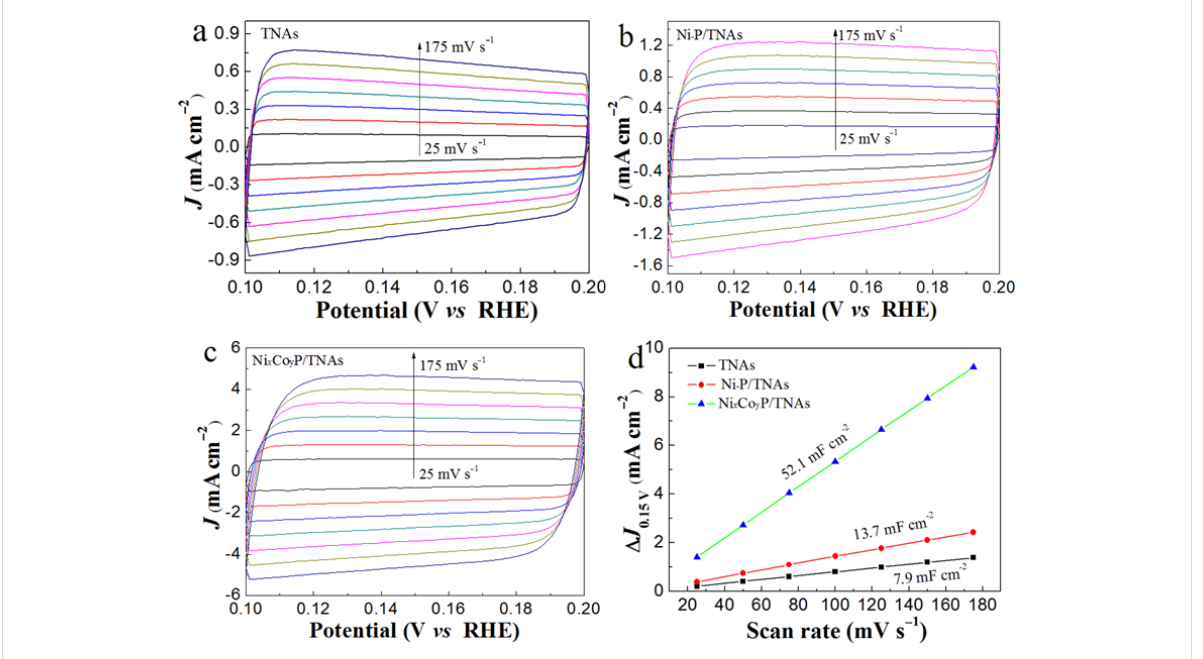
Figure 7: Cyclic voltammograms of (a) TNAs, (b) Ni–P/TNAs and (c) Ni x Co y P/TNAs at various scan rates (25–175 mV s − 1 ), and (d) corresponding current density scan rate curves to estimate the C dl and relative electrochemically active surface area.